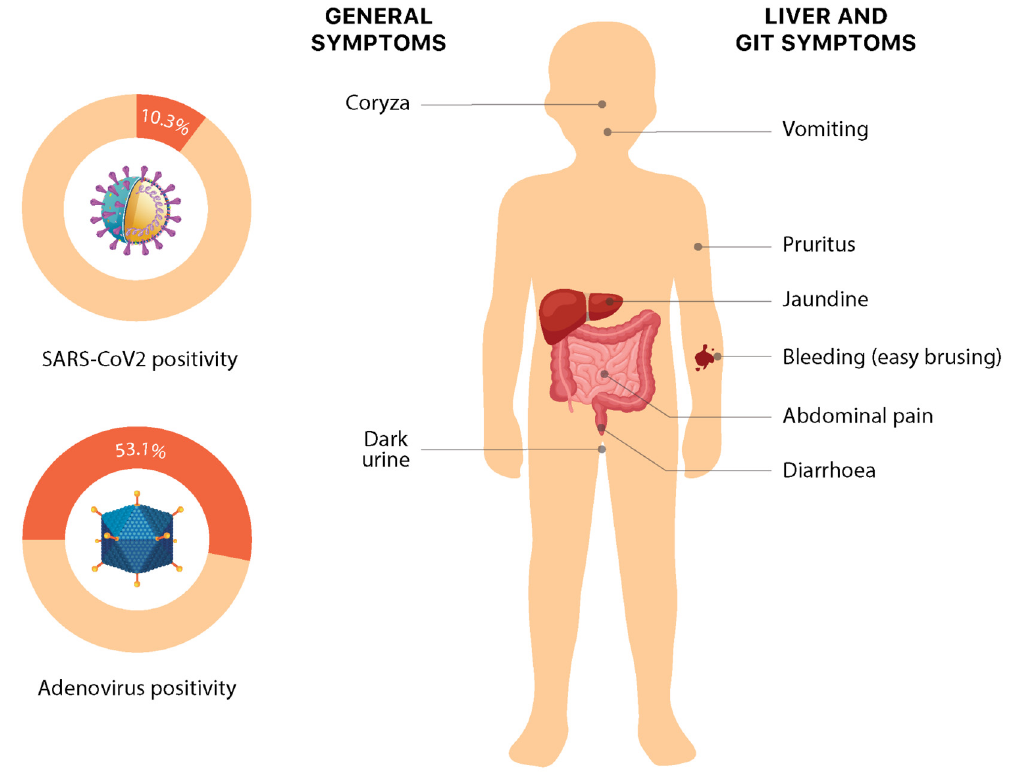
Figure 3. Symptoms and etiology of non-Hep A–E hepatitis. Numeric data is based on the latest available data from the European Region on 30 September 2022 [3].